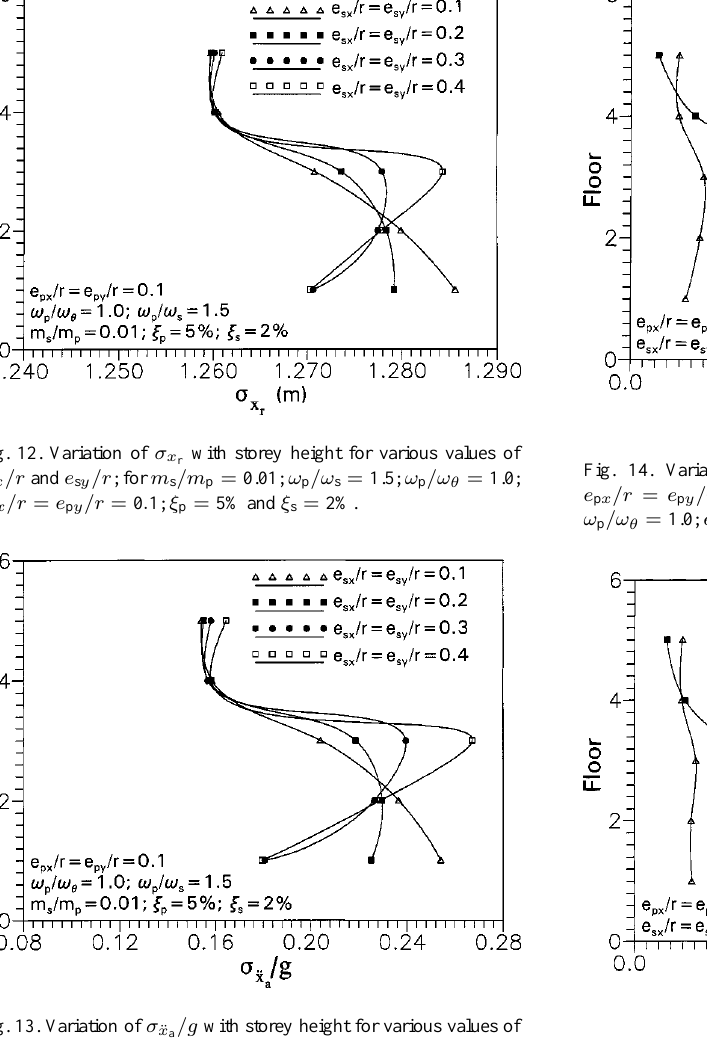
=g with storey height for Fig. 15. Variation of (cid:27) x and (cid:27) (cid:127) x r a e p x =r = e p y =r = 0.1; for m s =m p = 0.01, 0.05; ! p =! s = 1.5; ! p =! (cid:18) = 0.5; e s x =r = e s y =r = 0.3; (cid:24) p = 5% and (cid:24) s =